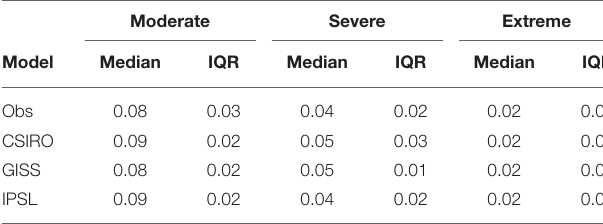
Comparison of measured and modeled data. Units: dimensionless.